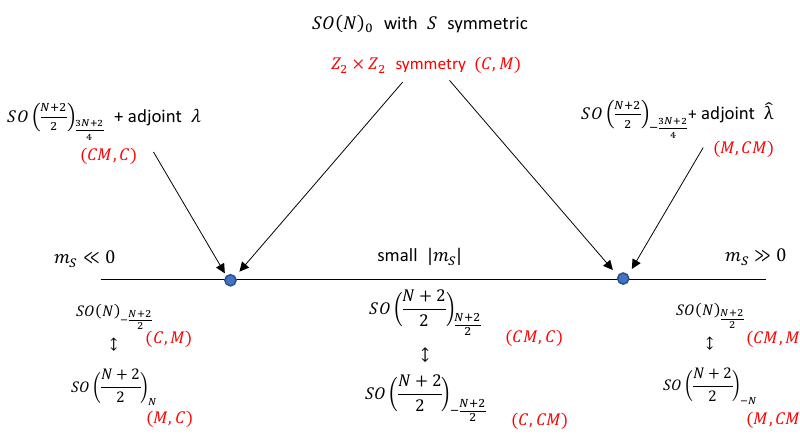
Figure 3: The phase diagram of SO ( N ) gauge theory coupled a symmetric tensor fermion S . The infrared TQFTs, together with relevant level-rank duals are shown along the bottom. The blue dots indicate the transitions from the semiclassical phase to the quantum phase. Each of these transitions can be described by a dual theory with adjoint fermions, in which the transition can be seen at weak coupling.